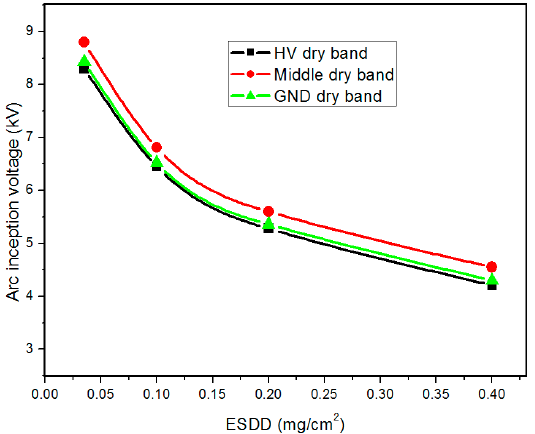
Figure 9. Arc inception voltage at different dry band locations, where NSDD = 0.75 mg/cm 2 , humidity level = low, temperature = 10 °C, and standard deviation = 3.0%–5.15%.